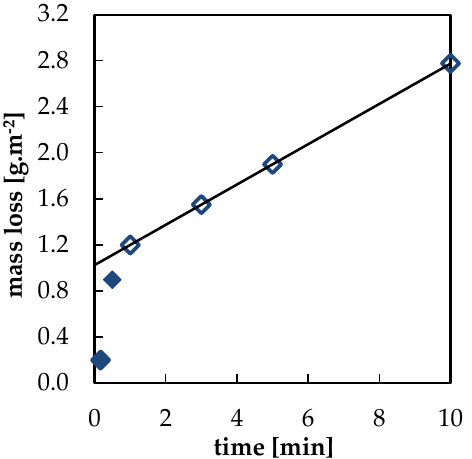
Figure 3. Interval cleaning of blank specimen in 1% HCl water solution; (cid:169) dissolution of an oxide layer; ♦ dissolution of metallic lead.